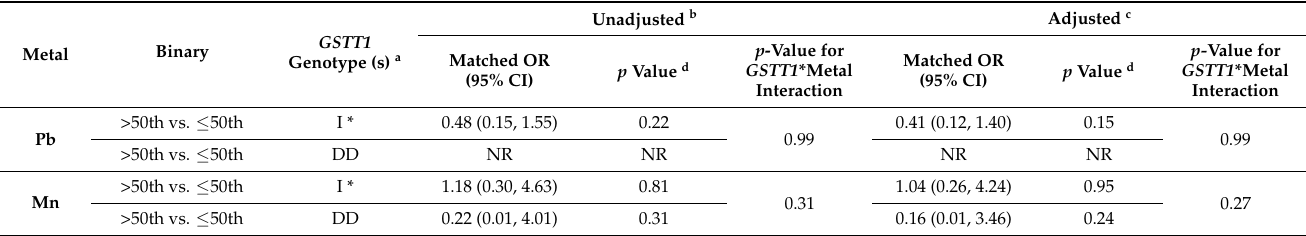
Table 4. Potential interaction of GSTT1 genotypes with blood Lead (Pb), Manganese (Mn) concentration in relation to ASD in Pakistani children based on CLR model. (N = 30 matched pairs or 60 children).